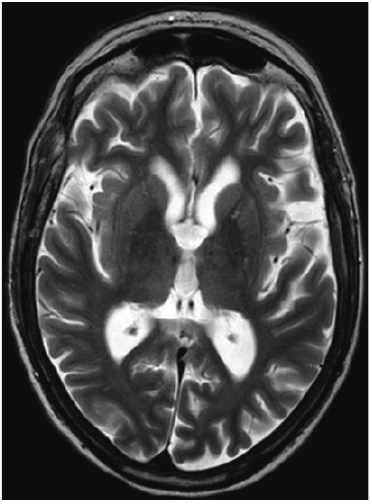
Figure 1: MRI brain showing CSF spaces and cerebral atrophy that are prominent for a patient of this age.